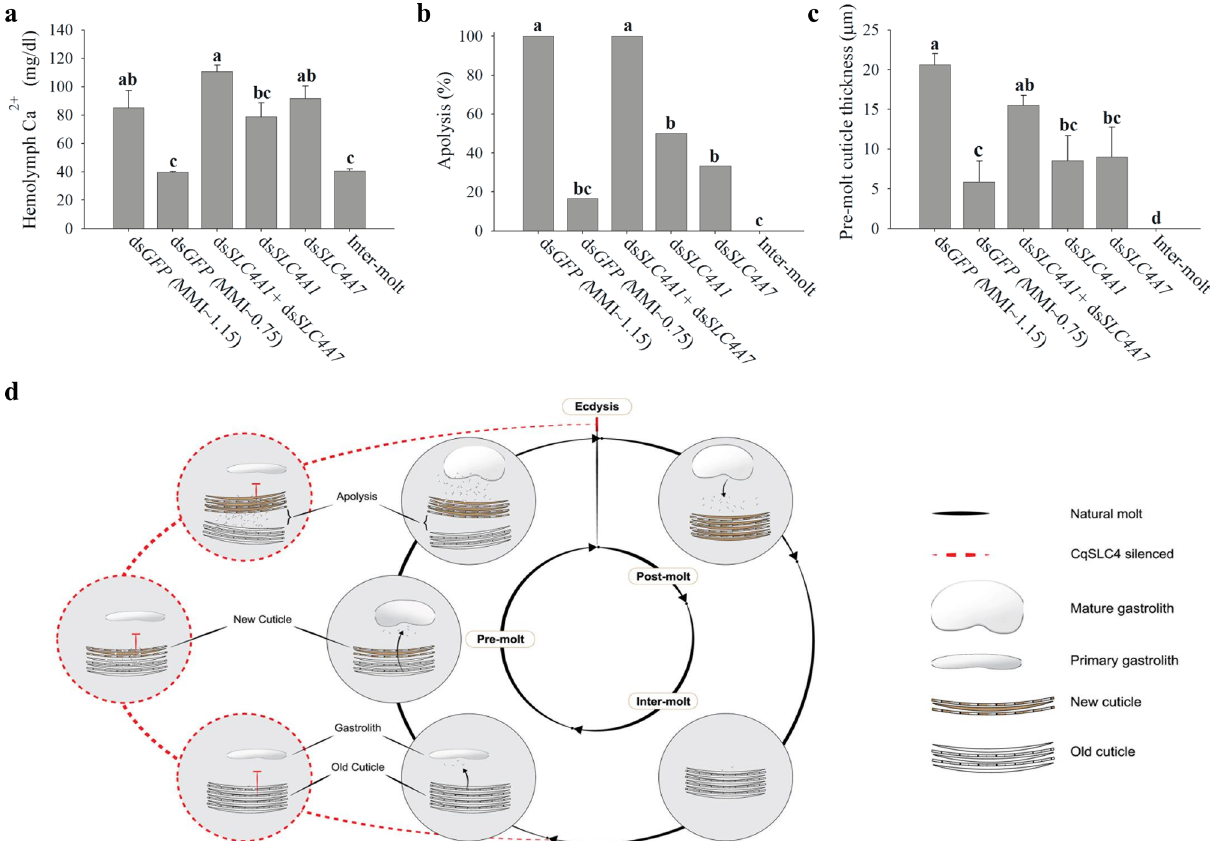
Figure 5. Temporal silencing of SLC4 transporters during the molt cycle leads to uncoupling of molt and mineralization. ( a – c ) The molt-related physiological parameters, Ca2+ concentration in the hemolymph, apolysis, and pre-molt cuticle thickness, are shown for three treatment groups silenced with dsSLC4A1 + dsSLC4A7, dsSLC4A1, or dsSLC4A7 and harvested at MMI ≈ 0.75, a negative control group harvested at inter-molt (MMI = 0) versus two control groups injected with dsGFP and harvested at either MMI ≈ 0.75 or prior to molt at MMI ≈ 1.15. ( d ) Schematic representation of the coupling between the mineralization of cuticular structures of C. quadricarinatus and molt cycle events. Molt cycle events occurring in the two main cuticular structures of C. quadricarinatus , the cuticle and the gastrolith, namely, the mineralization of the gastroliths at pre-molt, the demineralization of the old cuticle at pre-molt, the transfer of calcium from the old cuticle to the hemolymph at pre-molt, the formation of a new non-mineralized cuticle underneath the old cuticle at pre-molt, apolysis and separation of the newly forming cuticle from the old cuticle at late pre- molt, demineralization of the gastroliths at post-molt, mineralization of the newly formed cuticle at post-molt, and formation of a mature cuticle at inter-molt. The right side of the figure shows uncoupling of gastrolith mineralization from the different molt cycle events during pre-molt due to silencing of CqSLC4A1 and SLC4A7 during